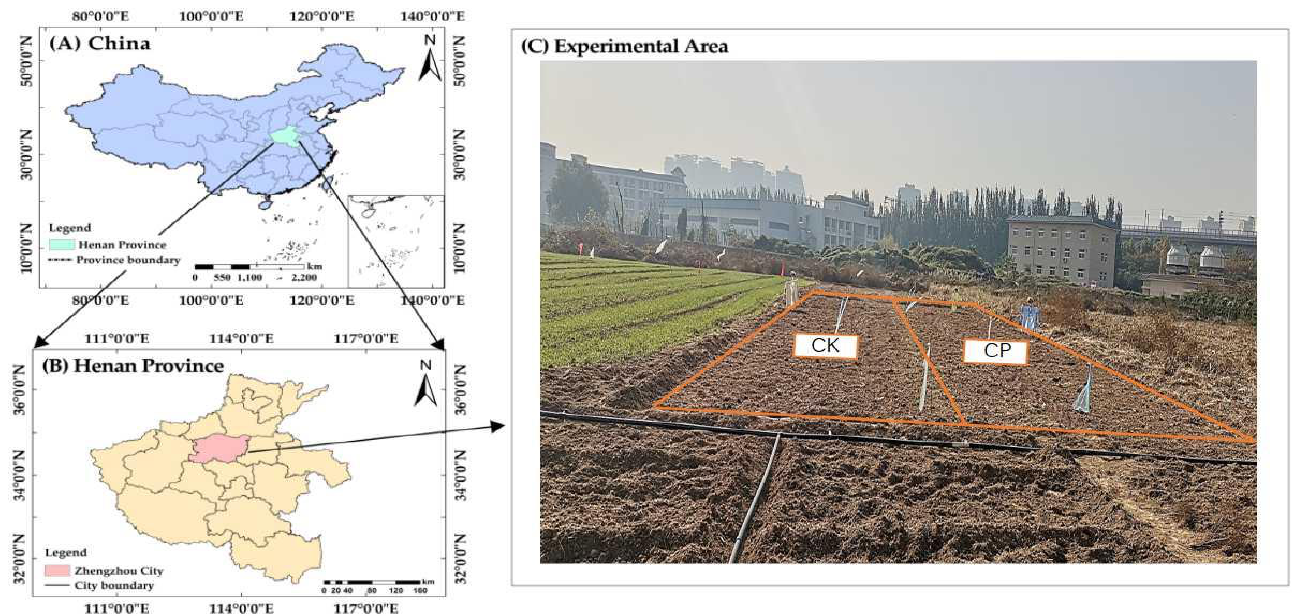
Figure 1. Study area diagram. ( A , B ) represent the location of the study area, ( C ) represents the spatial distribution of the study area and the boundary of cultivated land. CK represents the treatment without fertilization, and CP represents the treatment with organic fertilizer.